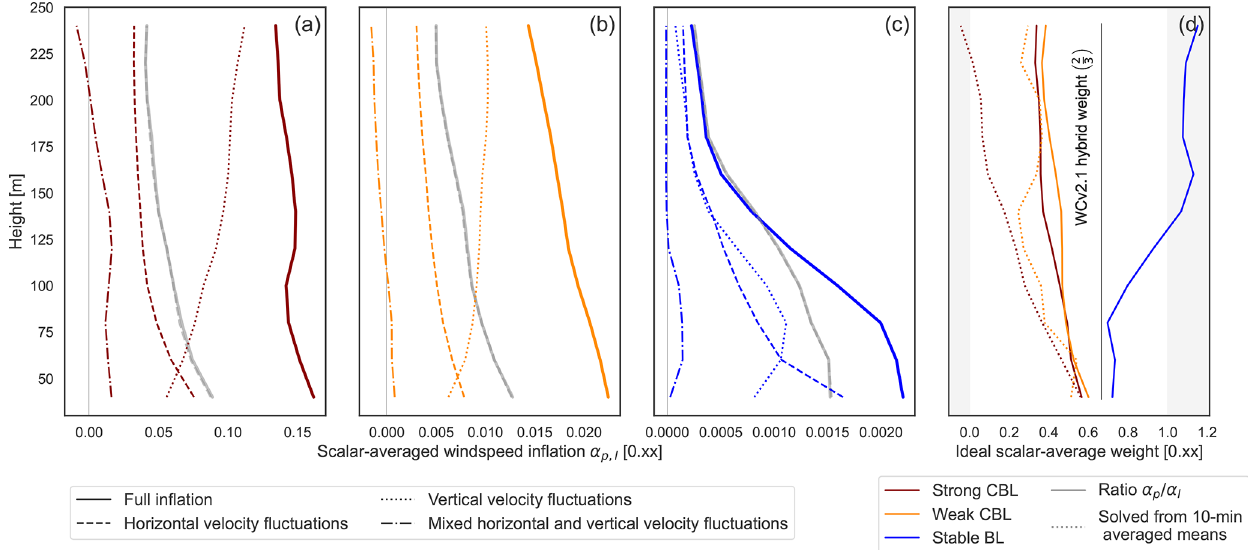
Figure 17. Decomposition of the lidar and pointwise scalar-average inflation factor ( α l and α p ) in the (a) strong CBL, (b) weak CBL, and (c) stable BL. Contributions to the inflation from horizontal ( u (cid:48) ,v (cid:48) ), vertical (w (cid:48) ) , and cross terms (u (cid:48) w (cid:48) ,v (cid:48) w (cid:48) ) with the lidar shown in color and the pointwise inflation in grey. (d) The ideal weighting for the scalar-averaged lidar measurement in a hybrid scheme computed from the ratio of pointwise inflation factors and solved directly from the 10min averaged mean